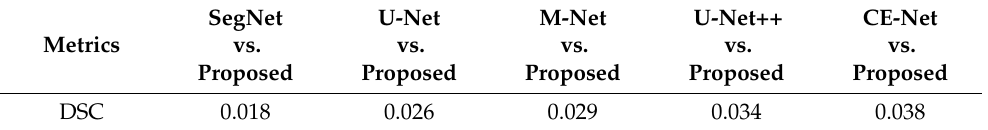
Table 8. p -values measured using Wilcoxon rank-sum analysis on the OASIS dataset.